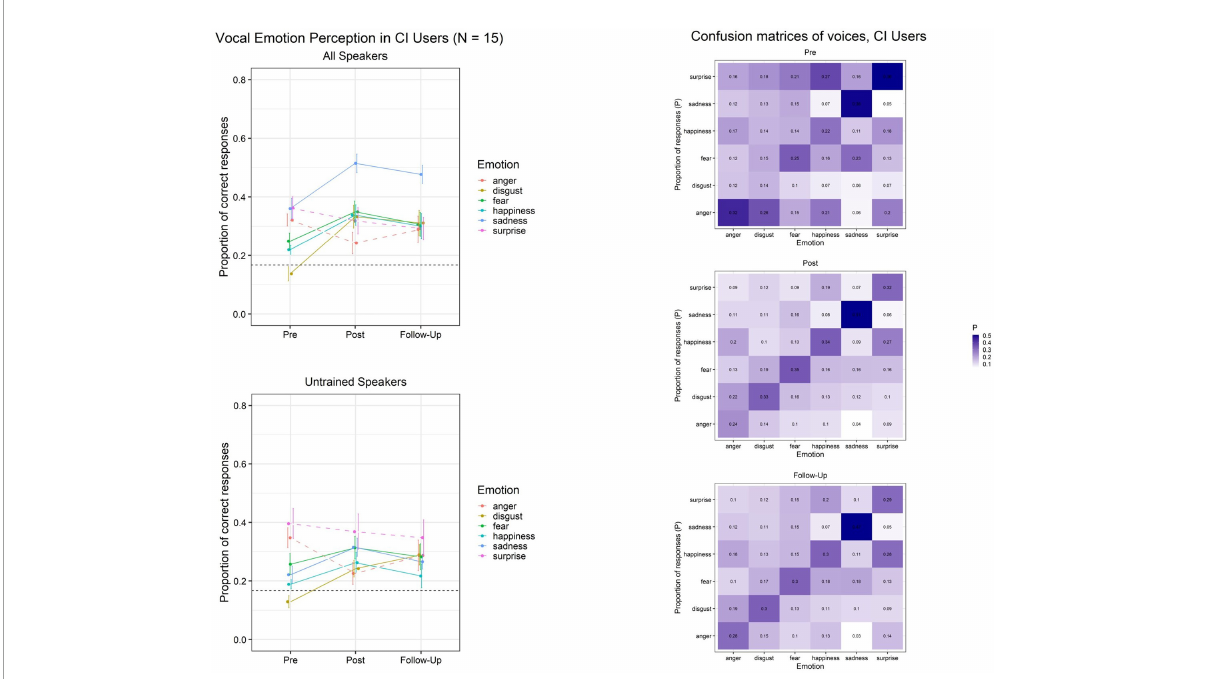
FIGURE2 Initial outcomes from an ongoing online training ( ∼ 30 daily training sessions á 64 trials/7 min). Adult CI users ( N = 15) were trained using caricatures of vocal emotions. Left: Lab data on vocal emotion recognition at pre-training, post-training, and follow-up. Training encompassed four emotions (disgust, fear, happiness, and sadness). Top Left: Data on utterances from all speakers. Consistent training benefits appear for trained but not untrained emotions, and are partially maintained at follow-up ∼ 8 weeks after training completion. Bottom Left: Data on utterances from untrained speakers only, who were never heard during training. Training benefits may generalize in attenuated magnitude across the same emotions when tested with utterances from untrained speakers. Dotted horizontal lines indicate chance levels for six response alternatives, and error bars indicate standard errors of the mean. Right: Confusion Matrices at pre-training, post-training, and follow-up. Darker hues along the diagonal (bottom left-top right) and lighter hues elsewhere correspond to better